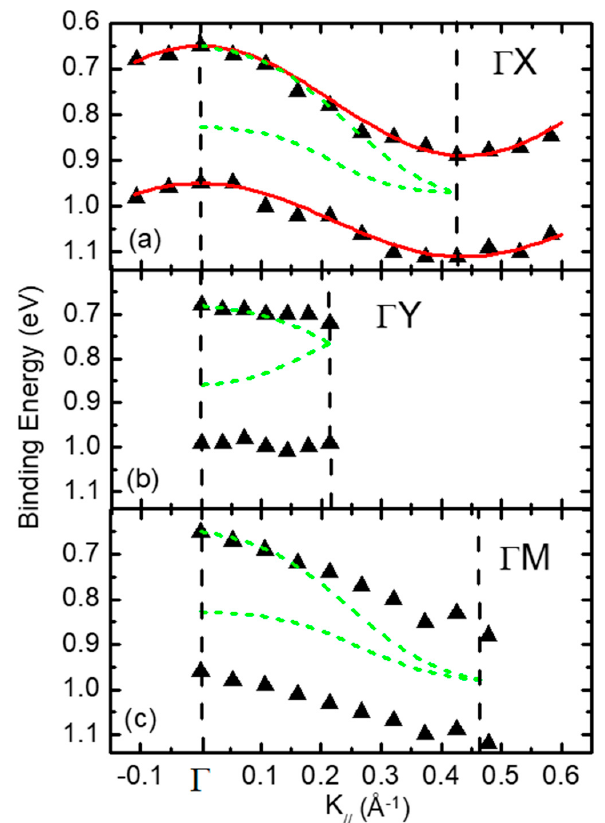
Figure 7. Band dispersions of the two HOMO-derived bands of single crystal rubrene along ( a ) Γ X, ( b ) Γ Y and ( c ) Γ M directions. The theoretical calculations from Ref. [61] are shown in the dashed lines. The solid curves are the dispersion obtained by analyzing the HOMO-B band using a simple tight-binding model. From Ref. [55] with permission.